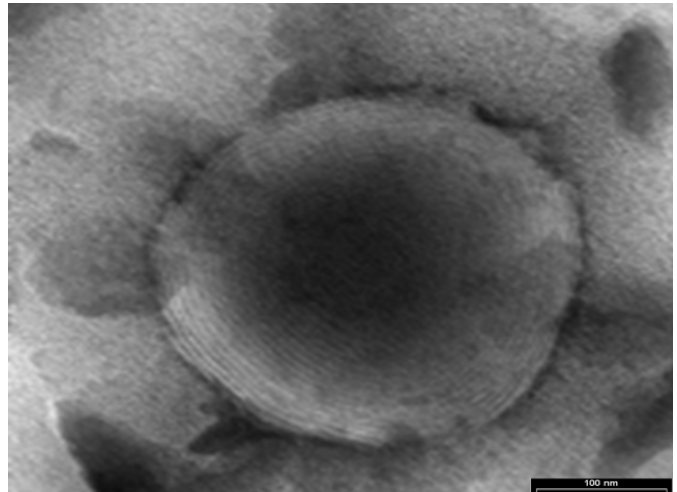
Figure 1. A multilamellar vesicle apparent in the transition electron (TE) micrograph of a buspirone